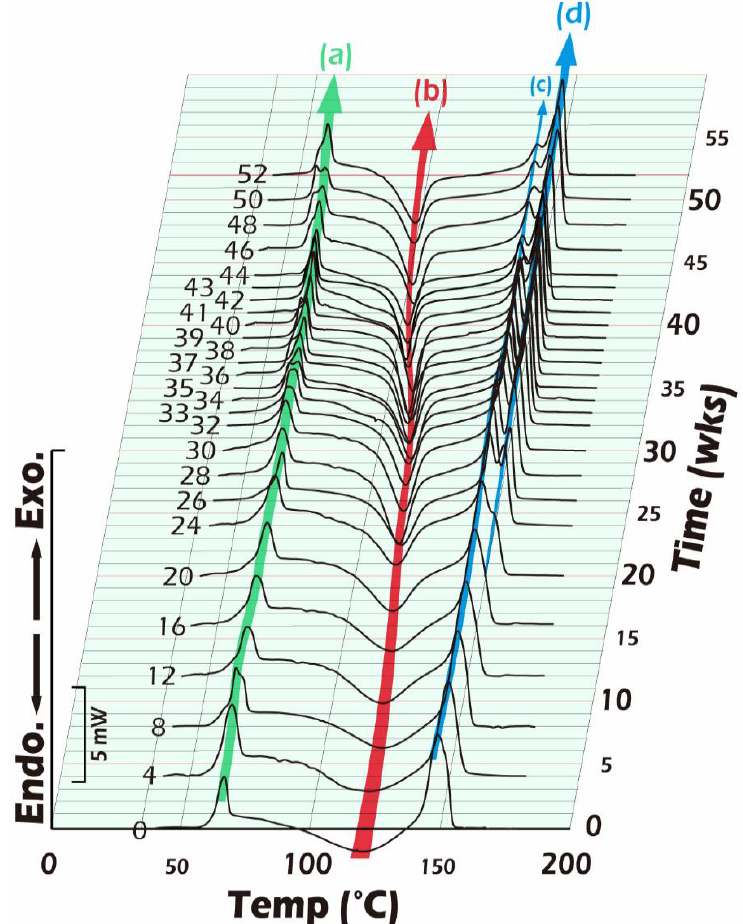
Figure 11. The 3D DSC thermograms of partially crystalline PLLA samples show the presence of the recrystallization phenomenon and melting shifting after hydrolysis in PBS for 1 – 52 weeks at 37 °C.